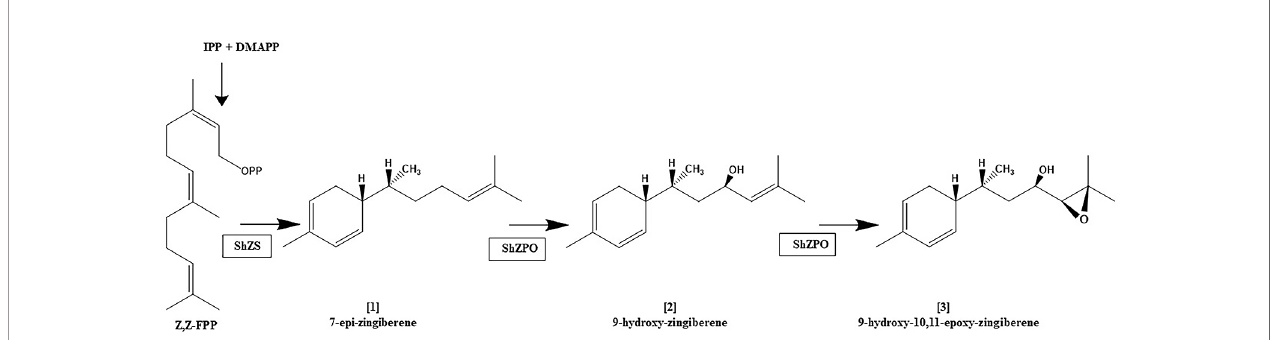
FIGURE 4 | Proposed biosynthetic pathway for the zingiberene derivatives present in trichome secretion of S. habrochaites accession LA2167. zFPS: Z,Z-FPP synthase, ShZS: zingiberene synthase (also referred to herein as ShZIS), ShZPO, zingiberene polyoxidase. This fi gure is based on information in Anonymous